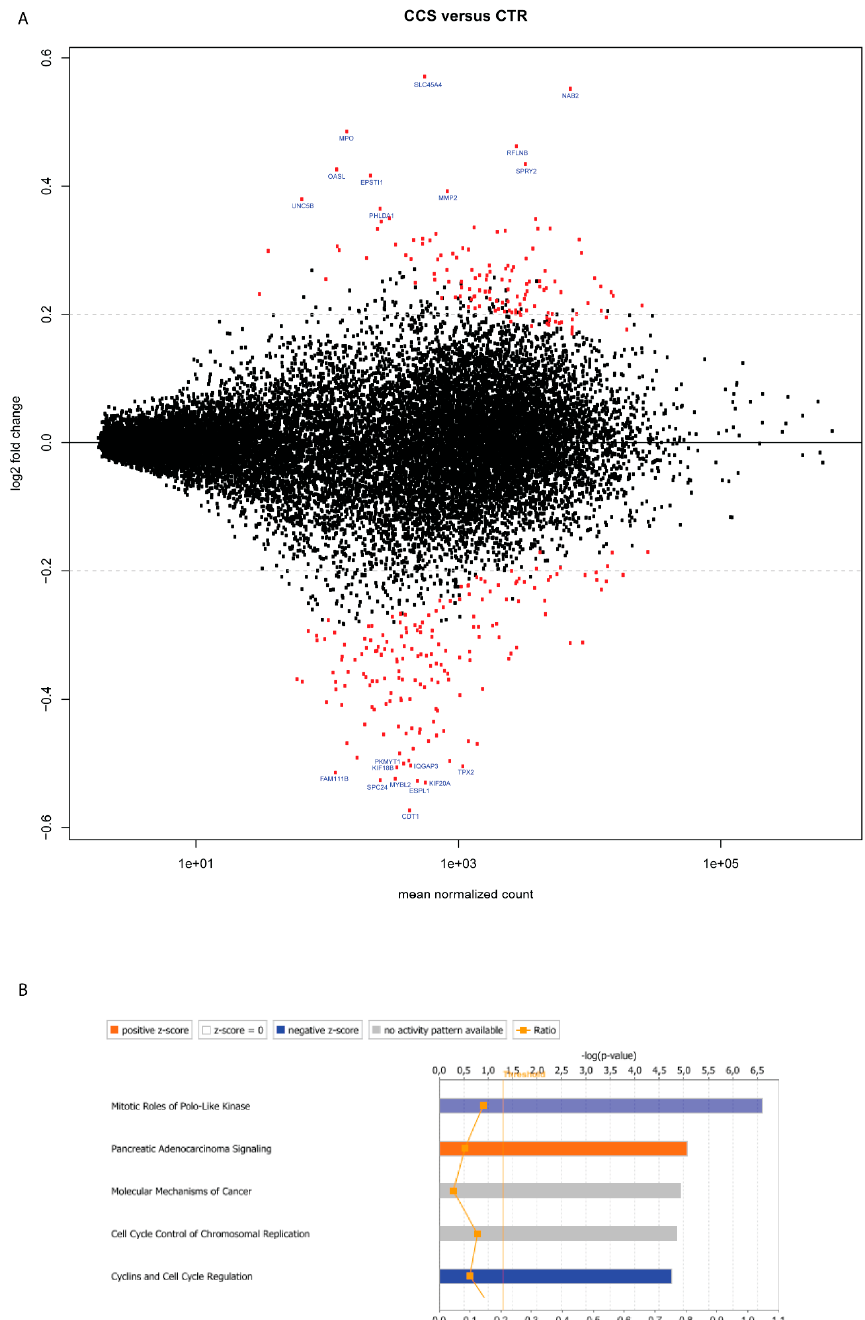
Figure 1. Deregulated genes in MCs cocultured with HT29 spheroids. ( A ) Plots of normalized mean count (gene expression) versus log 2 -transformed gene expression fold change (log 2 FC) for MCs cocultured with HT29 spheroids (CCS) versus MCs alone (CTR). Each dot represents a transcript. Dots in red were significantly differentially up- or downregulated ( p < 0.05) ( n = 2). Dots labeled with the gene symbol were the top 10 upregulated or downregulated genes. The p values were computed by the Wald test and corrected by the Benjamini-Hochberg procedure. The black horizontal line denotes the base line level and the grey horizontal line denotes the value of log 2 FC = 0.2. ( B ) The top 5 canonical pathways enriched in CCS. Pathways in red indicate activated and those in blue, suppressed. Pathways in grey indicate no functional prediction available. The vertical line denotes the significance level of α = 0.05. (- (cid:3) -) The ratio represents the number of genes from the dataset that are part of the